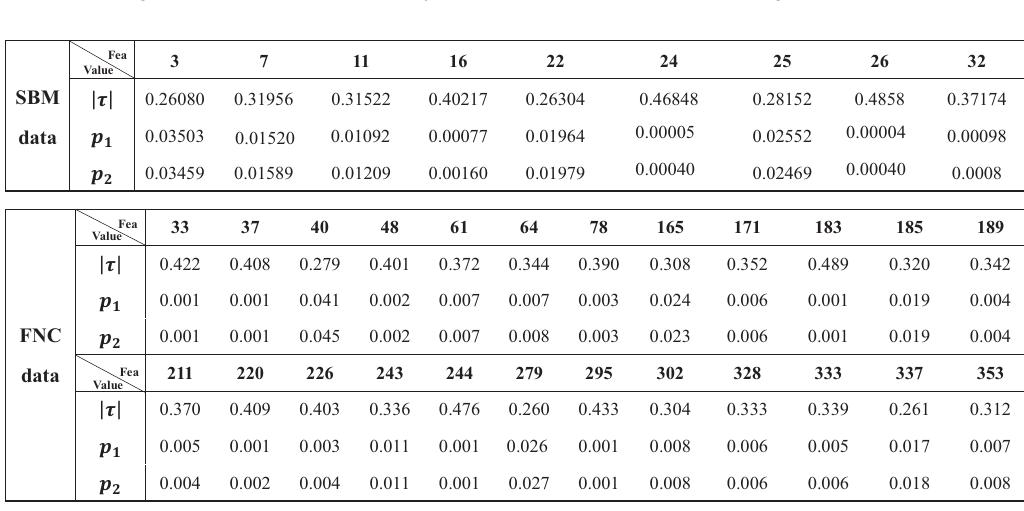
Figure 6. The results of hypothesis test for both two-sample t -tests and the permutation test. The x axis corresponds to the features, and the y axis is the significance level ( − log 2 P ) . The red and green lines show the significance levels of 0.05 and 0.01, respectively. The features with − log 2 P values above the lines have significant differences, and they are the candidates of abnormal regions or connections.